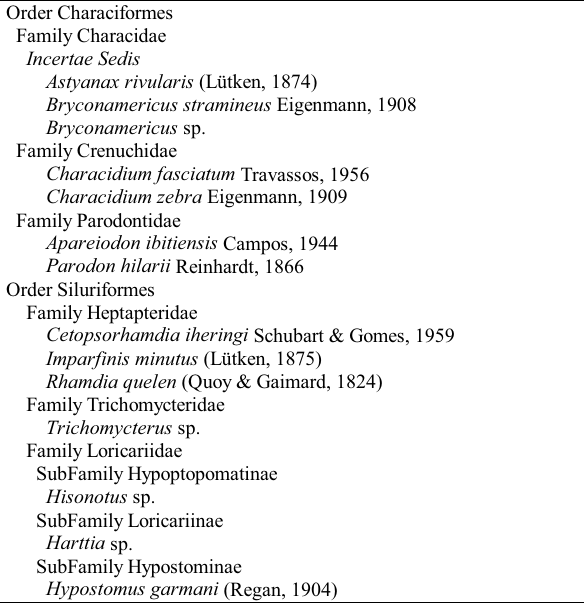
Table 1. Fish species resident in the studied upper rio São Francisco riffles, southeastern